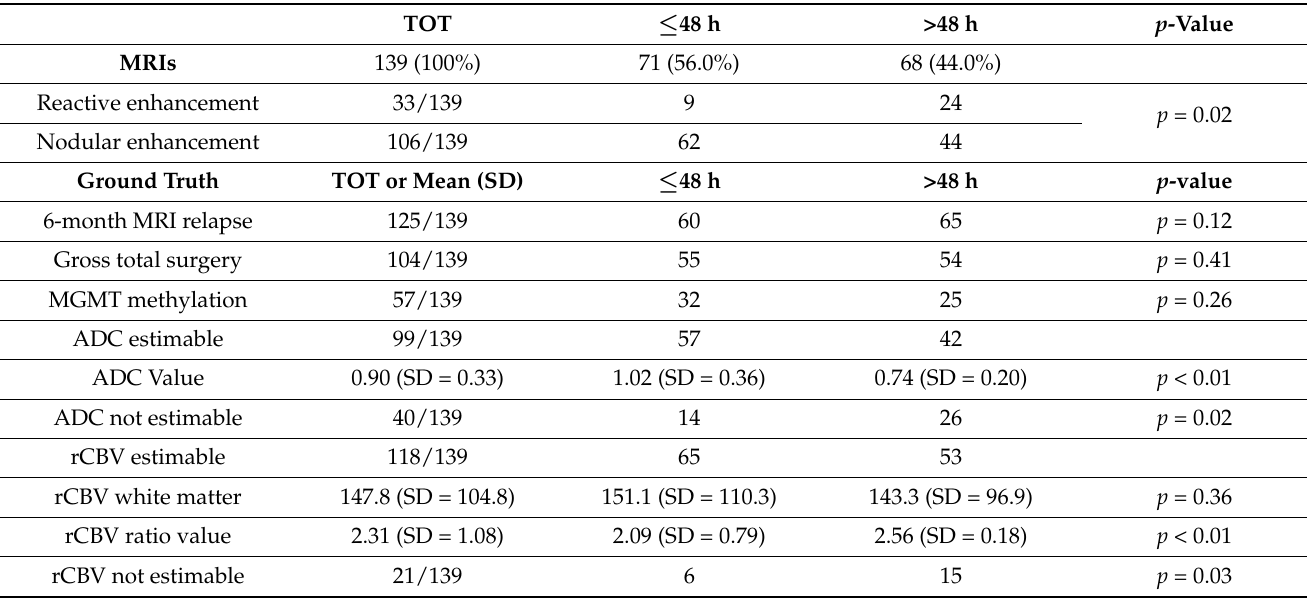
Table 2. Main MRI findings were identified in the two study groups with their respective p -values. In the second section, the follow-up relapse data and the number of patients undergoing total resection of the glioblastoma were